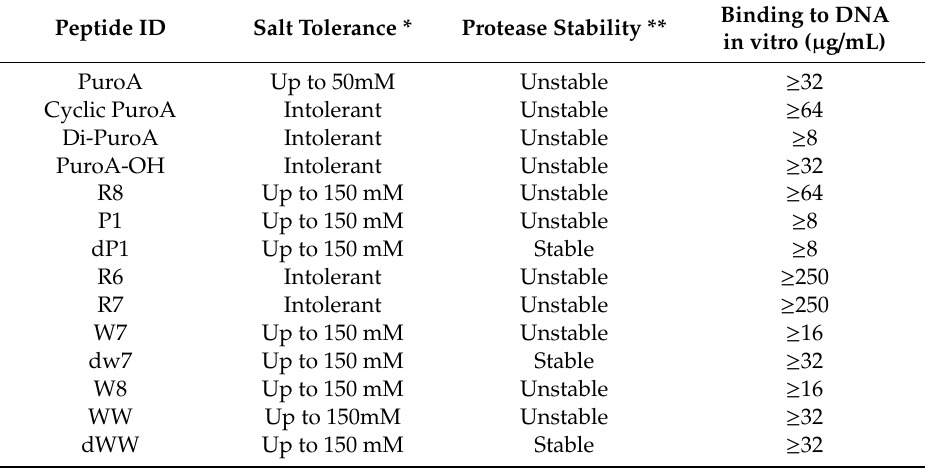
Binding to DNA in vitro ( µ g / mL)